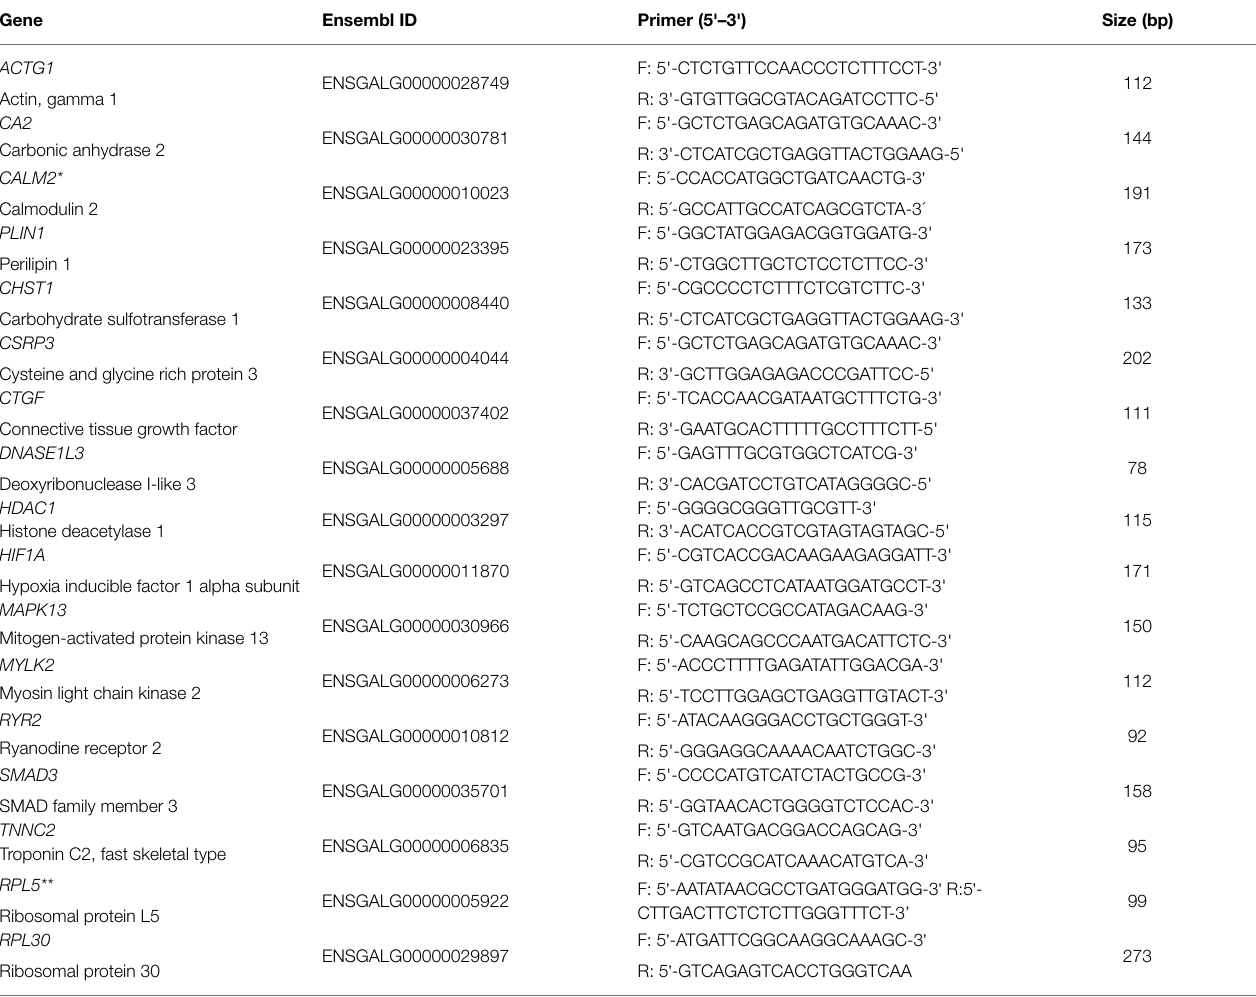
TABLE 1 | Primers for the 15 candidate genes and reference genes used for the quantitative PCR (qPCR) analysis in the breast muscle of normal and White Striping (WS)-affected broilers.